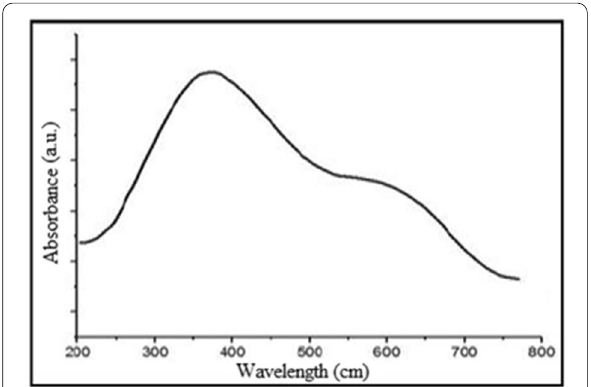
Fig. 1 UV–Vis absorption spectrum for Ag–TiO 2